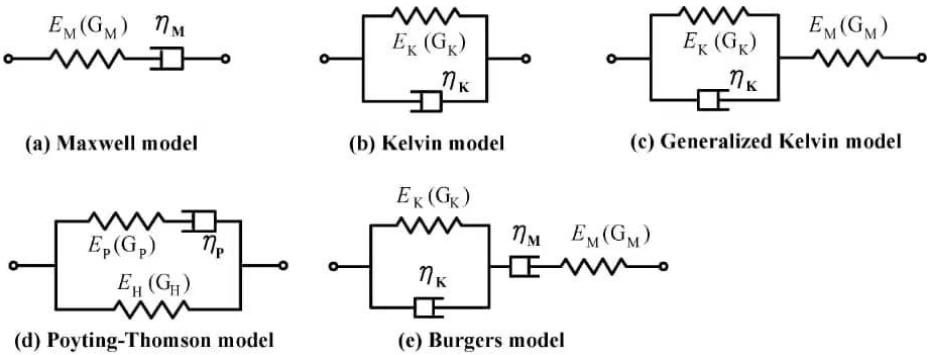
Figure 7. Common creep models with their characteristic parameters (from [143], Copyright©2022, with permission from the publisher, License No. 5333760872972).